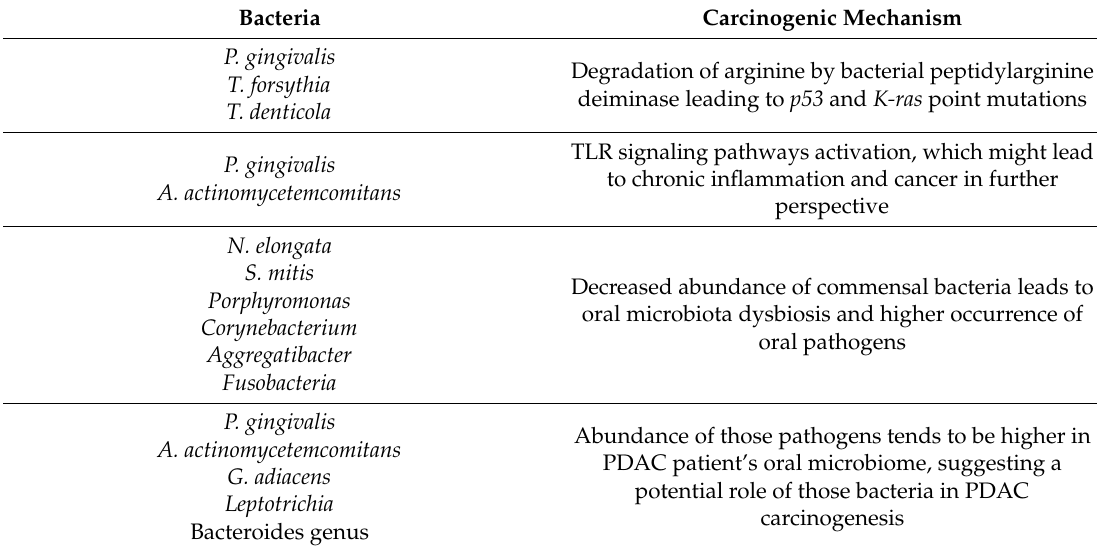
Table 4. Oral microbiota in pancreatic cancer. TRL, Toll-like receptor; PDAC, pancreatic ductal adenocarcinoma. Bacteria Carcinogenic